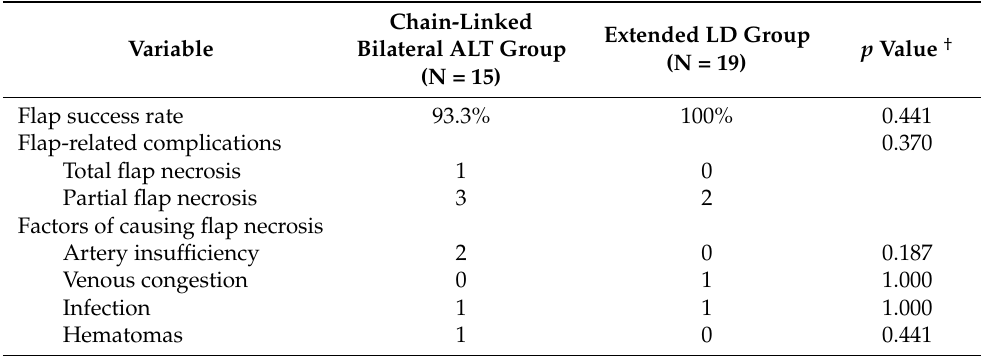
Table 3. Flap complications and